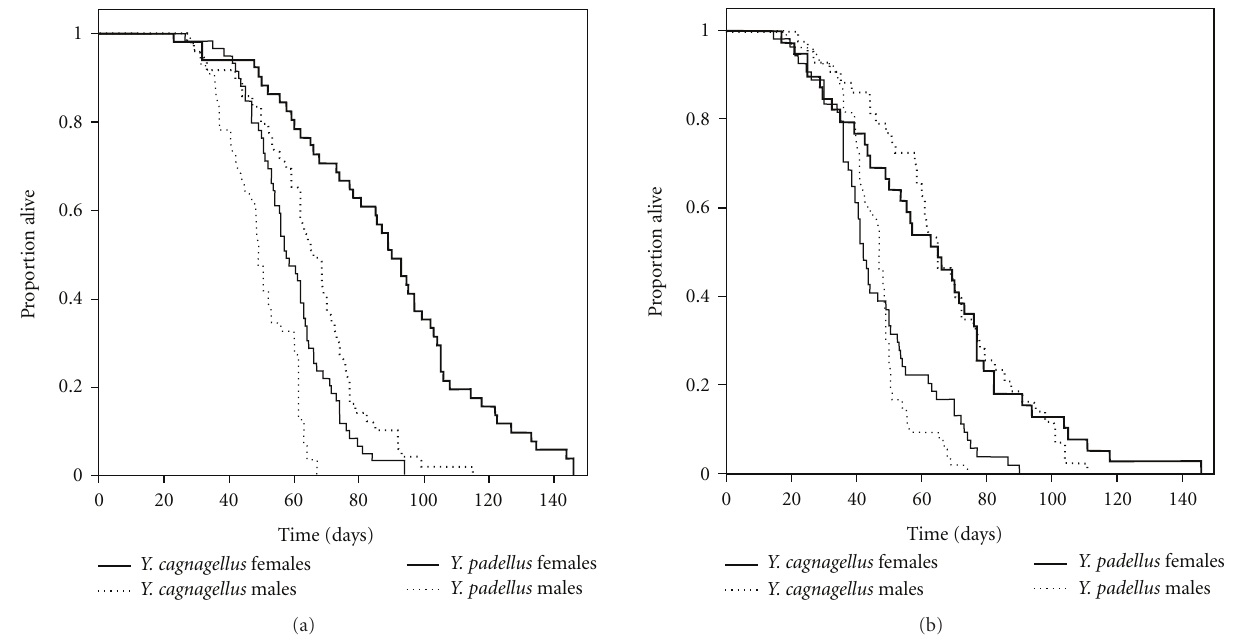
Figure 3: (a) Survival curves of virgin adult Yponomeuta padellus and Yponomeuta cagnagellus males and females. Day 0 is the day of eclosion. (b) Survival curves of mated adult Yponomeuta padellus and Yponomeuta cagnagellus males and females. Day 0 is the day of